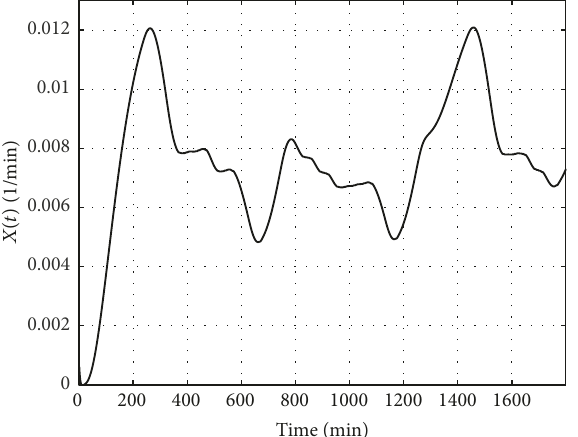
Figure 8: Variation of the insulin-excitable tissue glucose uptake activity over time.